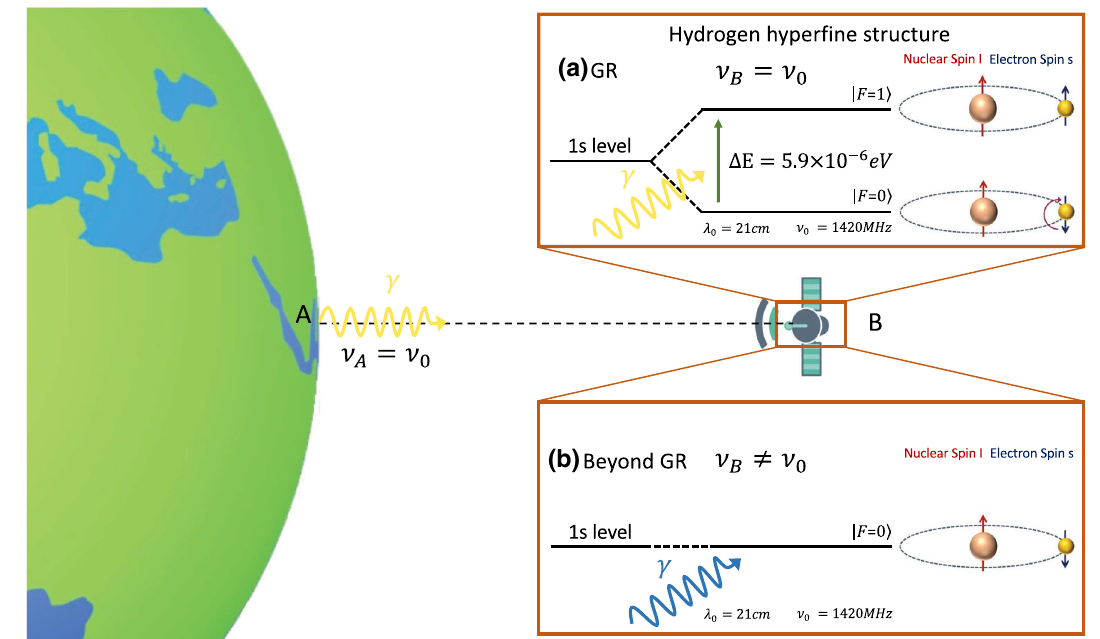
Fig. 2 Experimental device to measure the photon frequency shift: system of hydrogen atoms which can exhibit a spin-flip transition in the r A corresponds to an Earth-satellite 1s level. a In GR the orbit r B = 3 2 configuration at which the (static) pure gravitational contribution com- pensates the one related to the relative motion of the satellite with the respect to Earth. The static contribution to the frequency shift is zero ) . Thus, a photon with frequency r 2 (see Eq. (6)) up to order O (ω 2 A A ν = ν = 1420MHz sent by A would arrive in B with the same A B